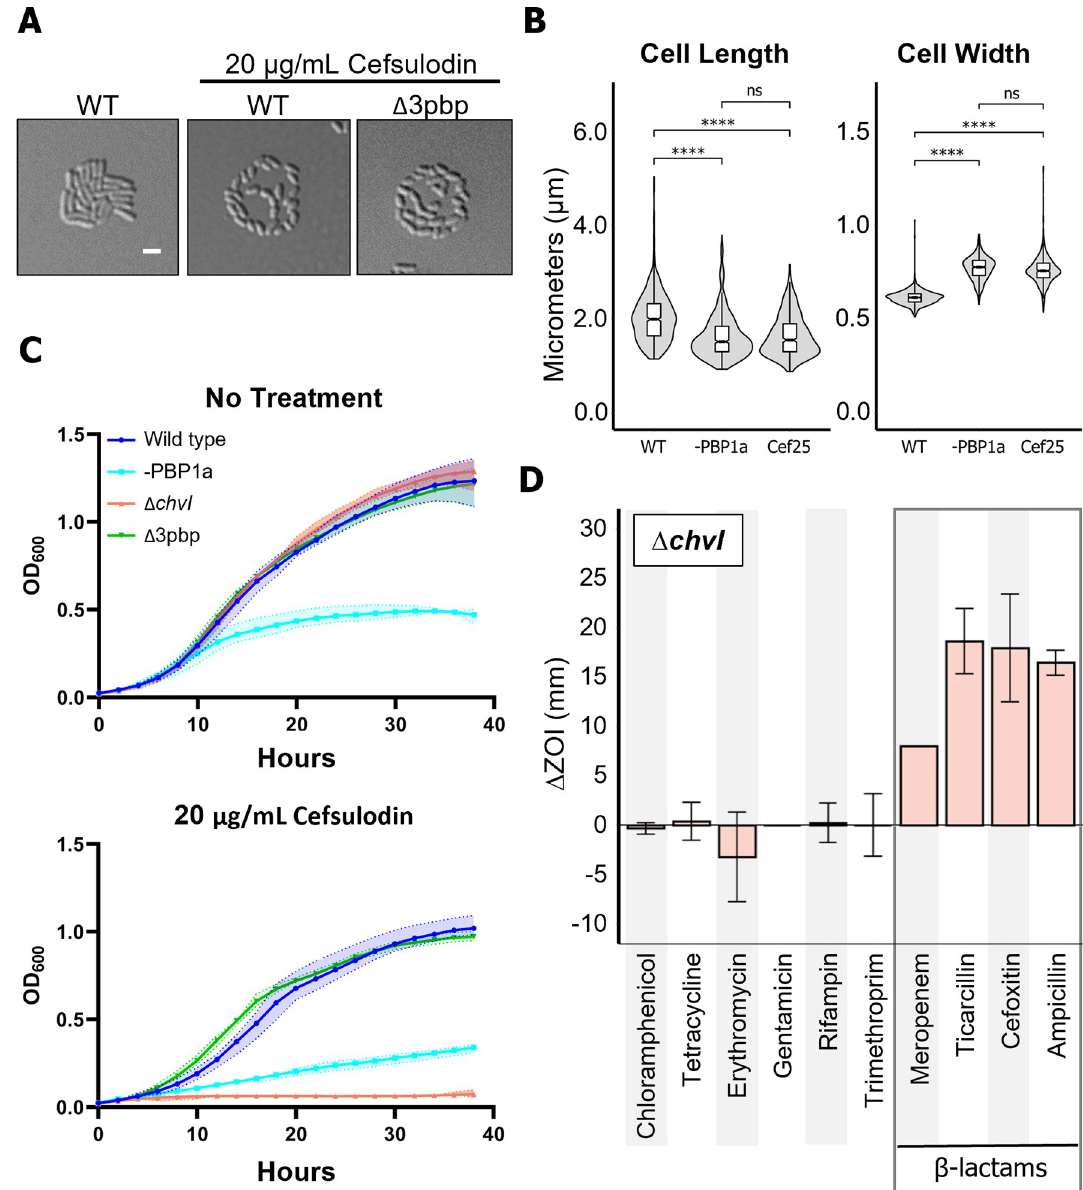
Fig 5. The ChvG-ChvI TCS is conditionally essential under treatment with β -lactam antibiotics. A. Micrographs of untreated and cefsulodin-treated cells. Wild-type and Δ 3pbp cells were grown to exponential phase, spotted on a 1% ATGN agar pad with or without 20 μ g/mL cefsulodin and allowed to grow for 16 hours. Each strain was imaged by DIC microscopy. B. Box plots comparing cell length and width between wild-type, PBP1a-depleted, and cefsulodin-treated cells. ns, not significant; ���� , p < 0.00005. C. Growth curves of WT, -PBP1a, Δ chvI , and Δ 3pbp in the absence (top) and presence of 20 μ g/mL cefsulodin (bottom). D. Graph depicting the change in zone of inhibition from wildtype in Δ chvI against ten different antibiotic disks. Error bars represent +/- 1 standard deviation from the